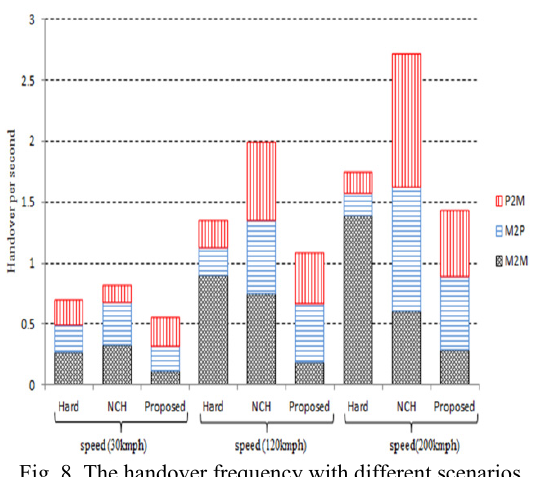
Fig. 8. The handover frequency with different scenarios.